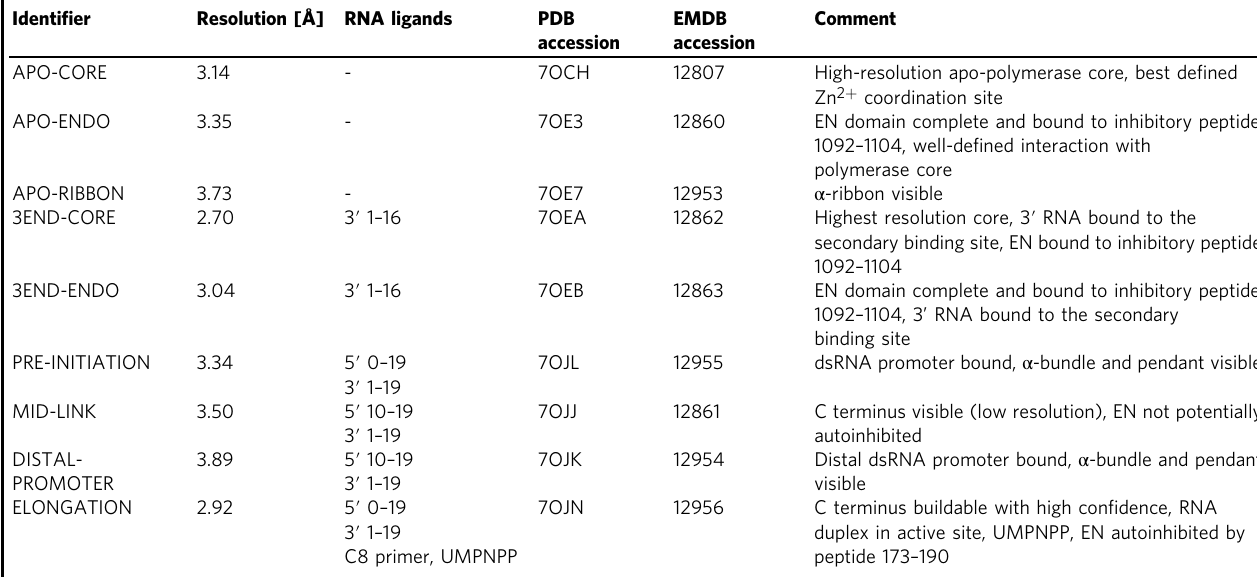
Table 1 Overview of the different LASV L protein